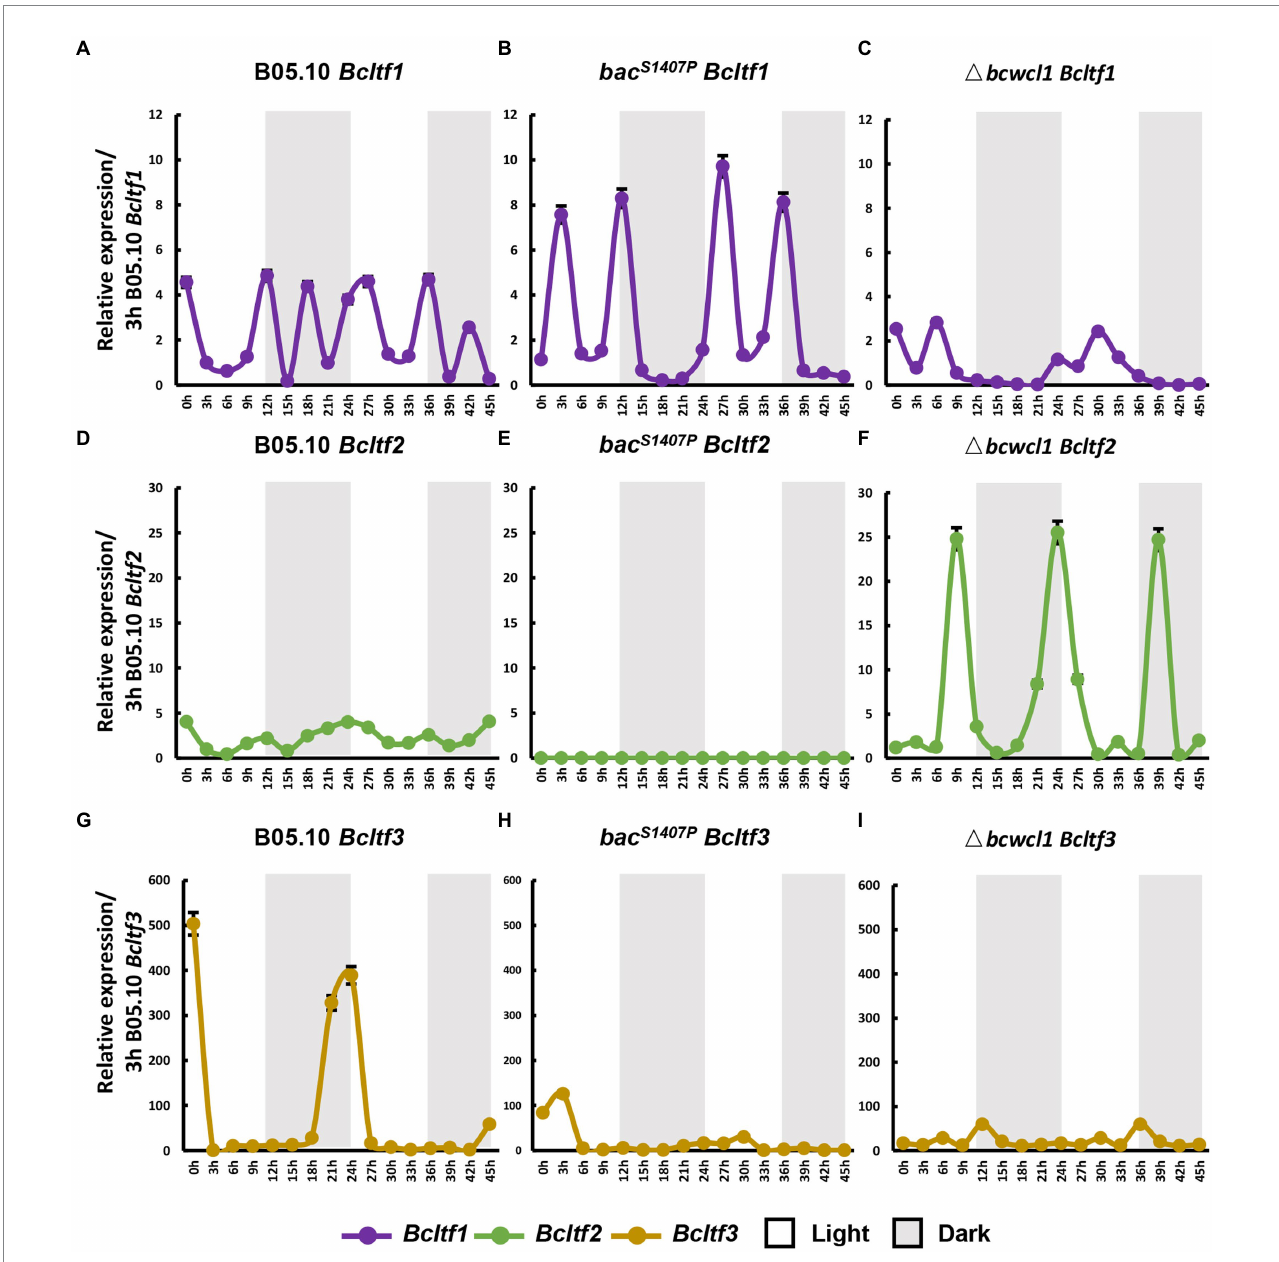
FIGURE 9 The conidia and sclerotia reproduction-related genes, Bcltf1 , Bcltf2 , and Bcltf3 in the wild type (B05.10) (A,D,G) , bac S1407P (B,E,H) , and Δ bcwcl1 (C,F,I) at different time points under LD conditions. The expression of B05.10 Bcltf1 (A–C) , B05.10 Bcltf2 (D–F) , and B05.10 Bcltf3 (G–I) recorded after 3 h was used as a ruler to compare the changes in the expression of genes at different time points under LD conditions for 2 days. Error bars represent standard deviations ( n =